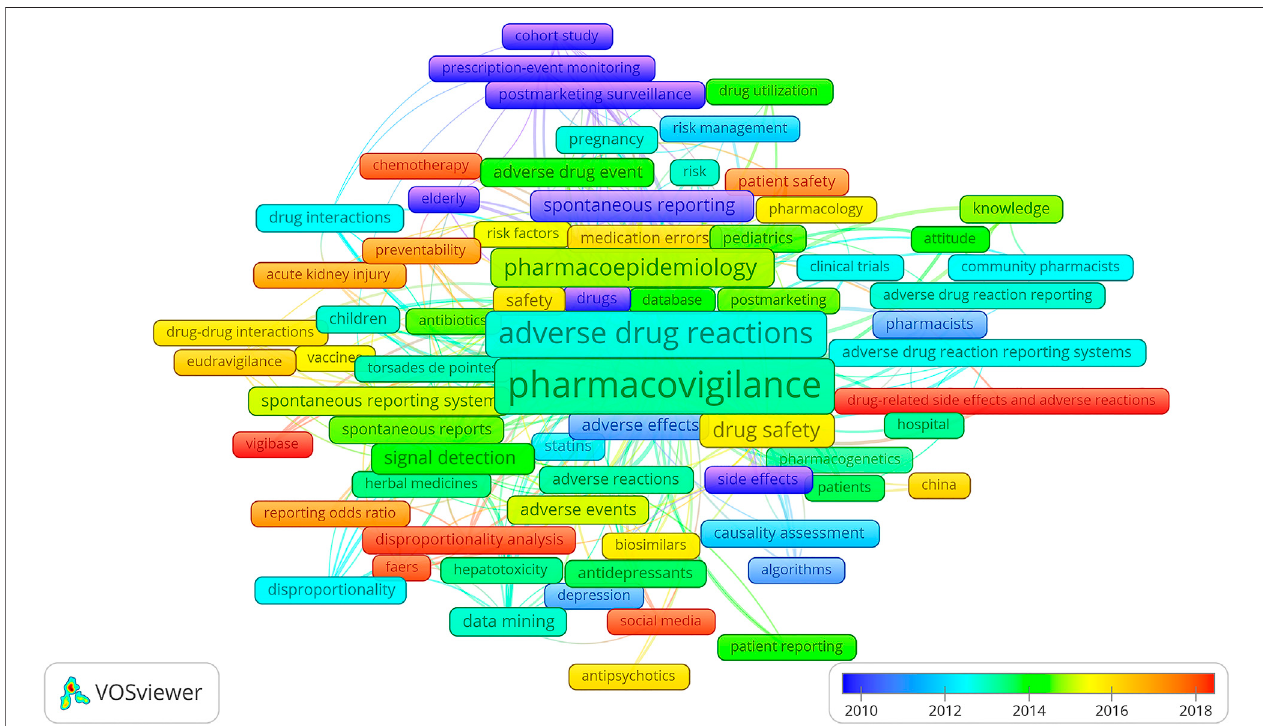
FIGURE 4 | Keywords ’ co-occurrence overlay mapping on pharmacovigilance from 1974 to 2021. Each frame indicates a keyword. The rainbow color marks the averagepublicationyearfromviolet(furtheryear)tored(recentyear)intherangeofspectrum.Thelargerscaleofakeywordisaccordingtothehigherfrequency,whilethe closer distance between the two keywords represents the stronger co-occurrence.